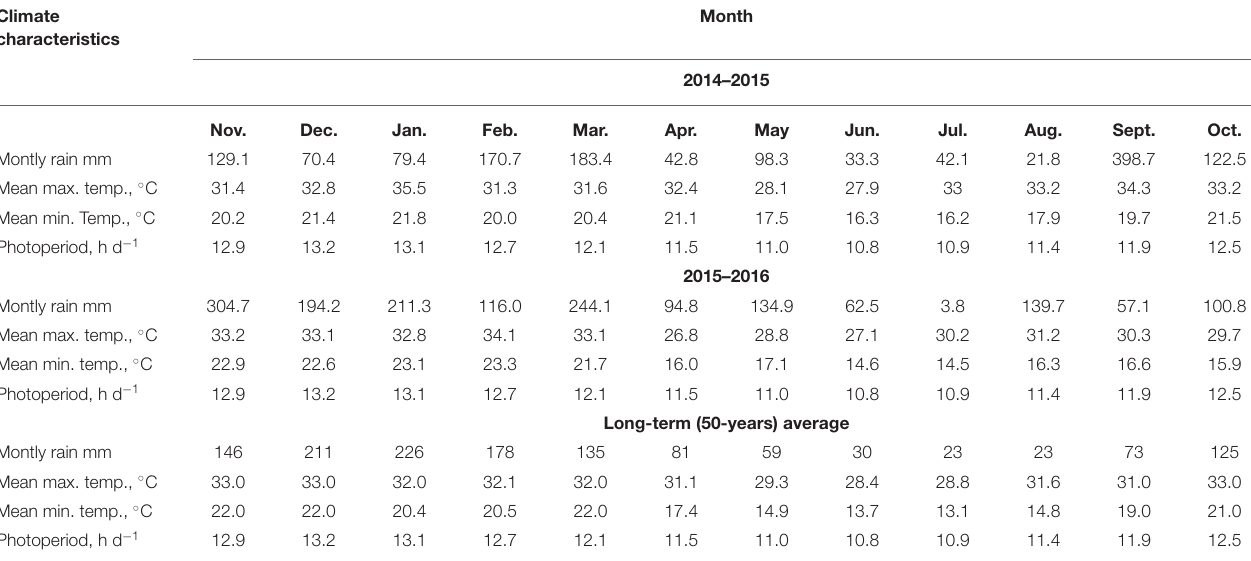
TABLE 1 | Rainfall, maximum and minimum temperatures, and photoperiod during the study period. Climate characteristics